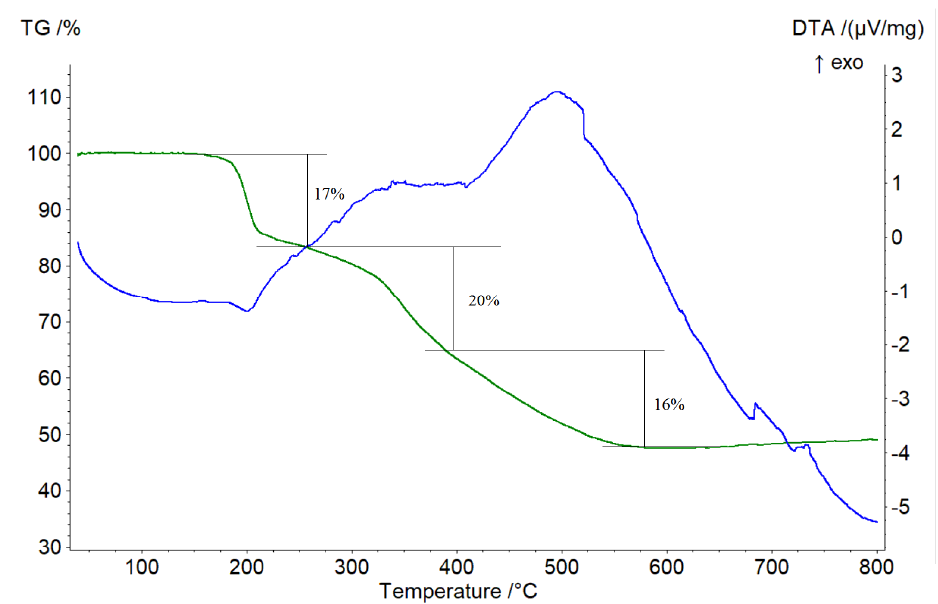
Figure 9. TG − DTA decomposition data of TcO(Pyr) 2 Cl 2 OMe in the Ar − H 2